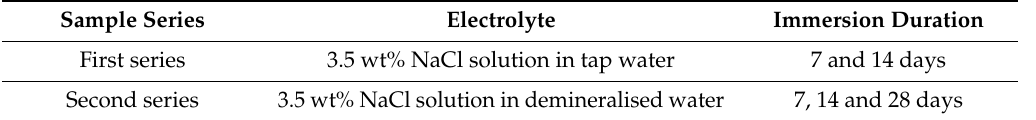
Figure 2. Geometry of samples used for fatigue testing (mm).